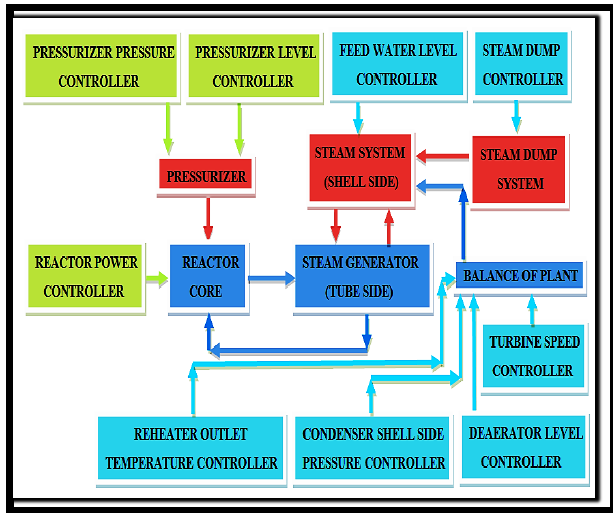
Fig. 2. Coupling of FO-MMF-VB and